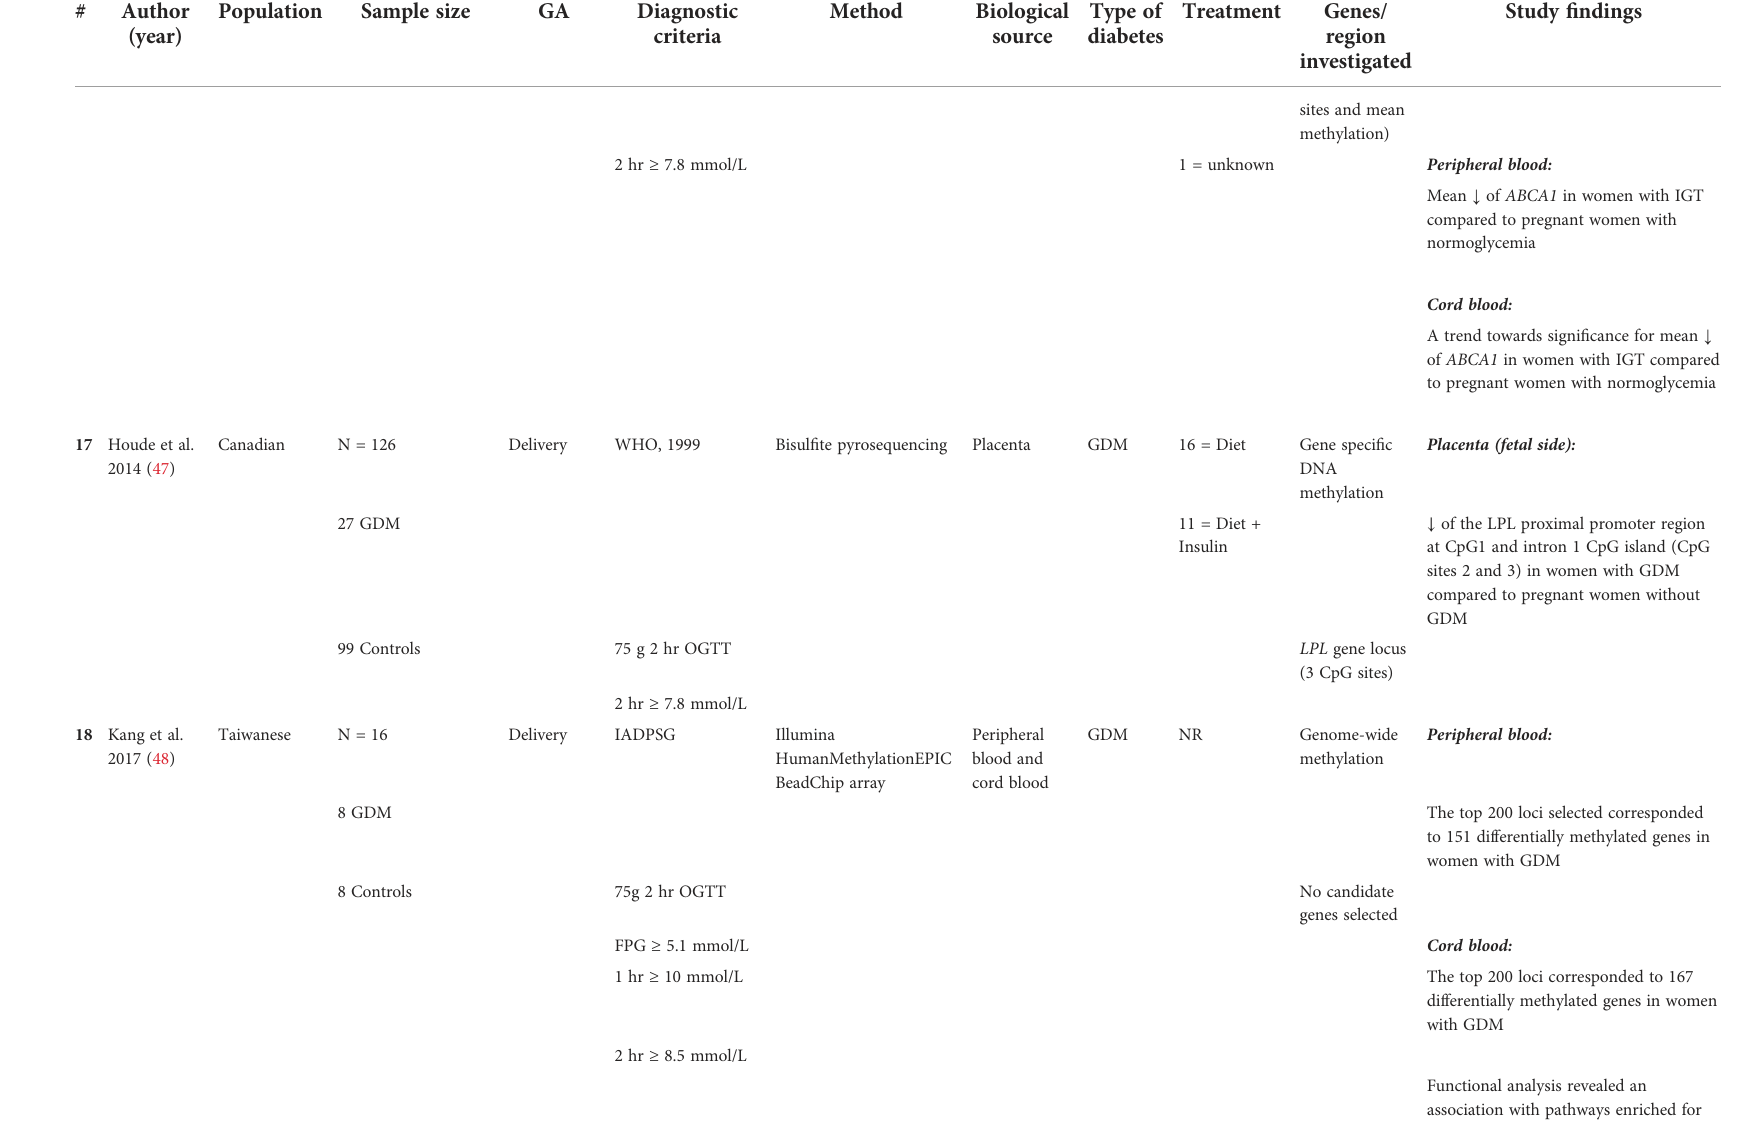
1 = unknown Peripheral blood: Mean ↓ of ABCA1 in women with IGT compared to pregnant women with normoglycemia